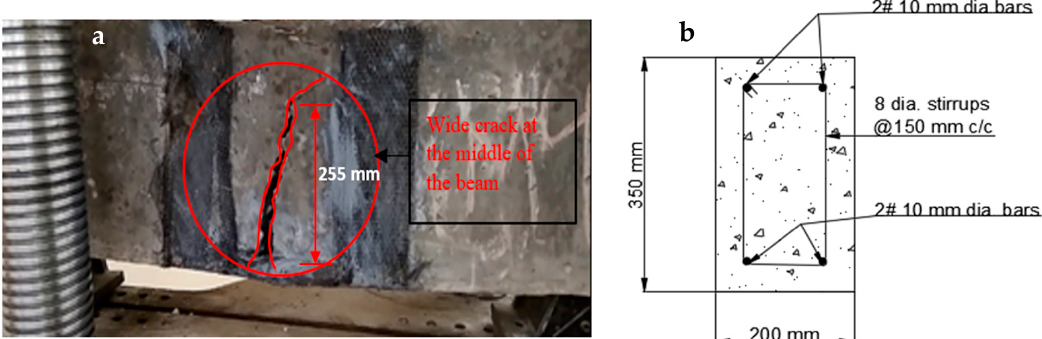
Figure 22. ( a , b ) Crack induced in a beam at the center.